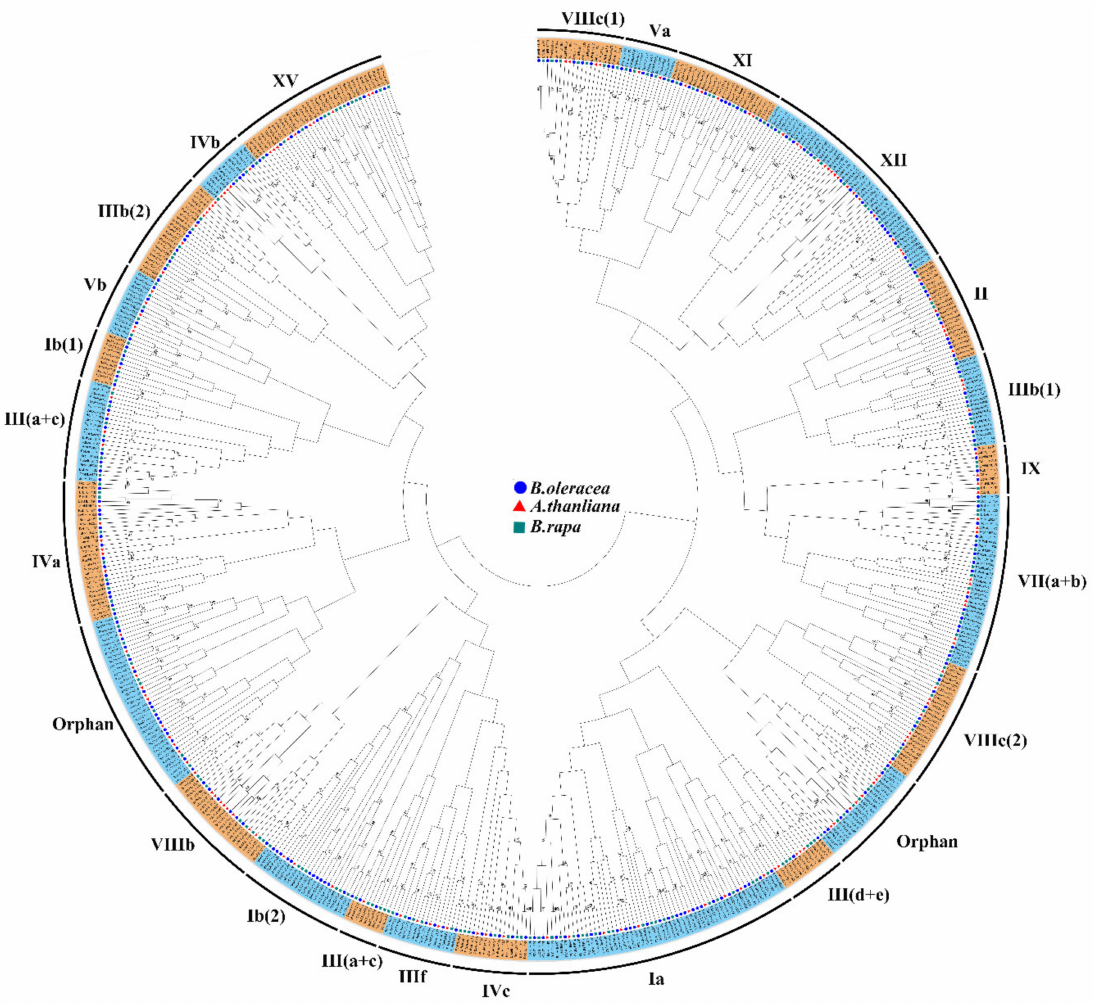
Figure 1. Phylogenetic tree of B. oleracea, A. thaliana, and B. rapa basic helix–loop–helix (bHLH) proteins. Phylogenetic analysis of bHLH proteins from B. oleracea (234), A. thaliana (159), and B. rapa (230) showing similar groups in the three